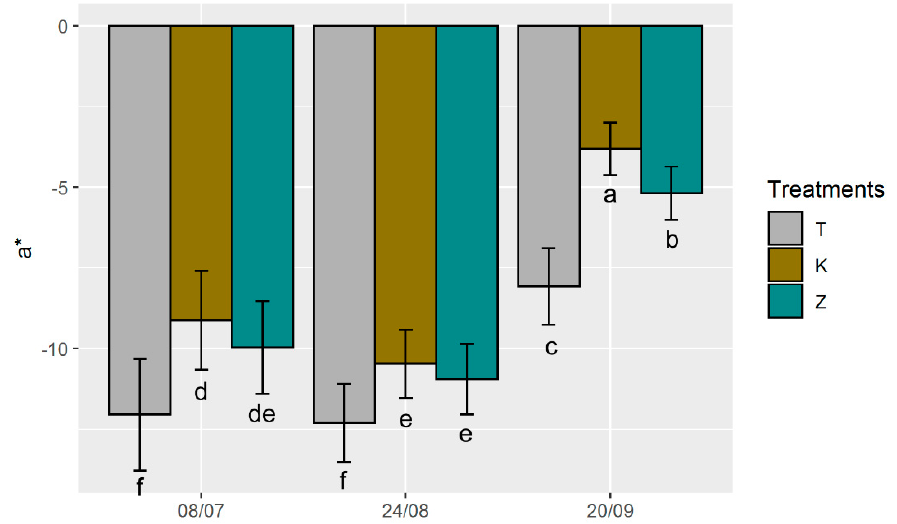
Figure 6. Changes in a*colour values measured on the upper part of the leaves of T (control), K (kaolin) and Z (CHA-zeolitite) treatments. Error bars represent standard deviation. Different letters above the bars for each group of histograms indicate significant differences according to ANOVA and Tukey’s HSD test ( p <